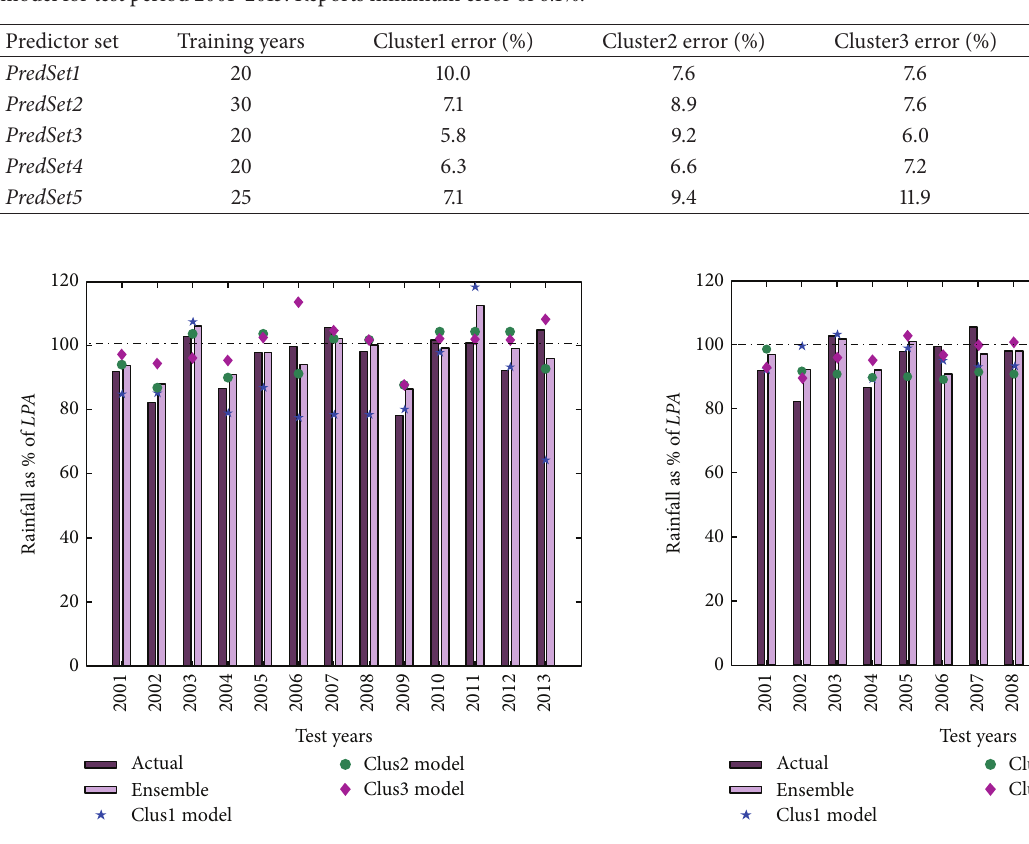
Figure 5: Performance of forecasts by proposed fuzzy clustering- based ensemble model and its respective three clusters models by RNN for PredSet3 . The deep and light purple bars represent the actual and predicted ISMR in terms of percent of LPA . The symbols represent forecasts given by individual cluster models. The results are shown for test period 2001–2013.